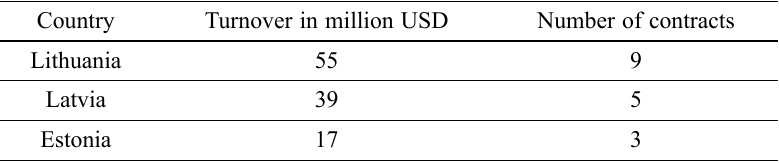
Table 1. Weekly average of turnover in million USD and a number of contracts from 12 September 2012 to 22 February 2013 of the Baltic countries’ CDS Country